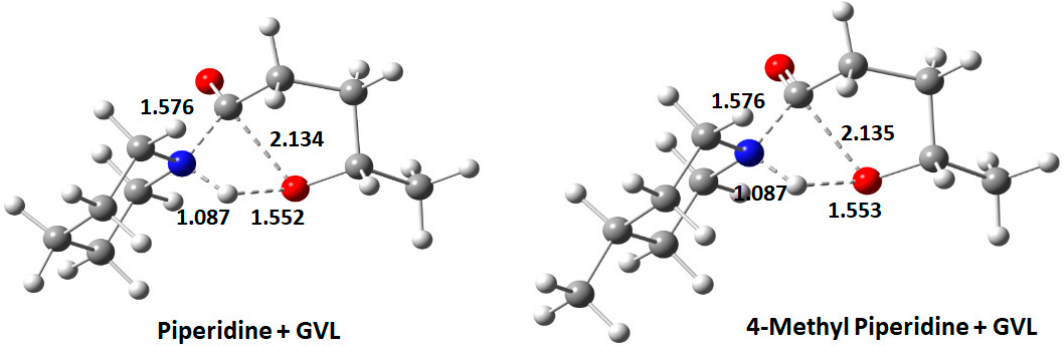
Figure 9. Transition state for PIP + GVL and 4-MP + GVL.